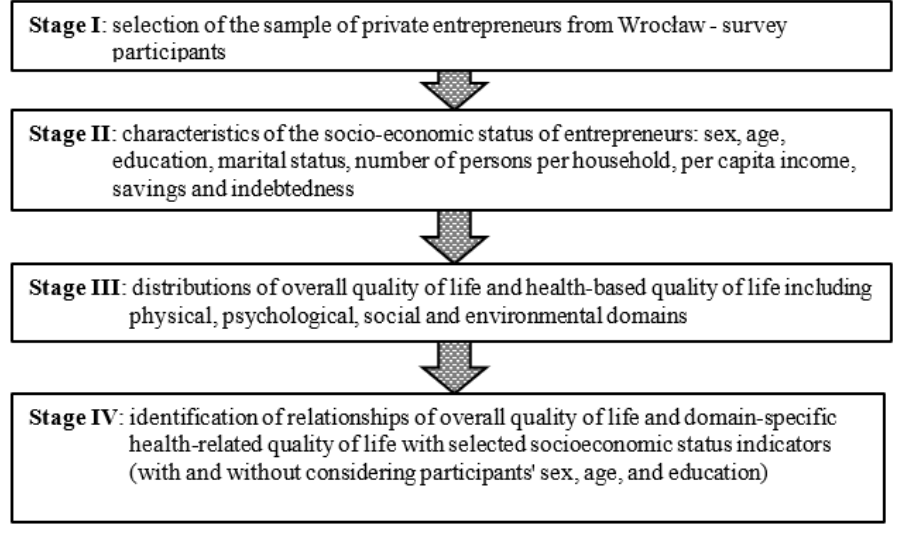
Figure 2. Four stages of the study. Source: author’s own.